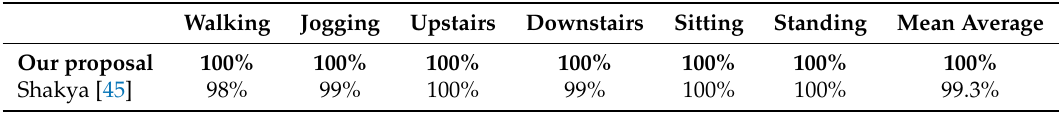
Table 7. Comparison performance of the most competitive method in detection of human motion activities recognition using WISDM